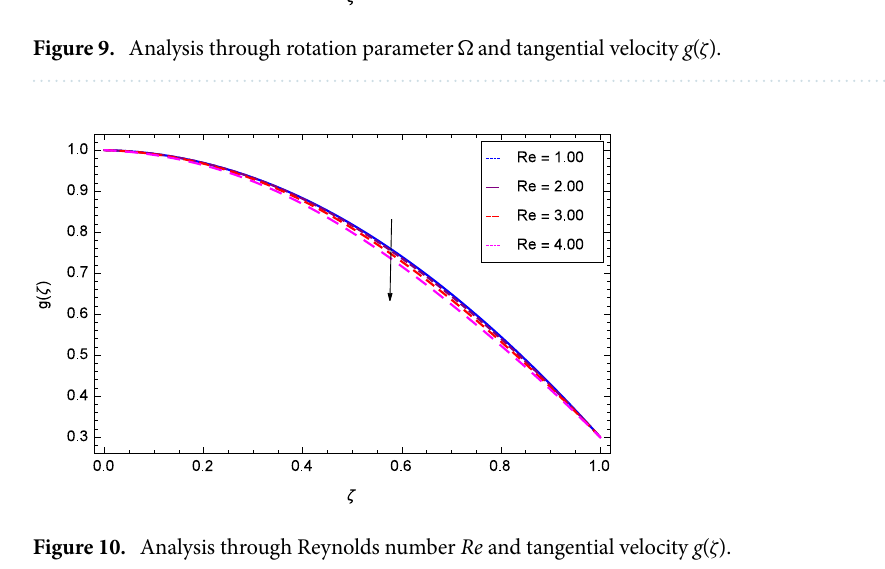
Figure 10. Analysis through Reynolds number Re and tangential velocity g ( ζ ).